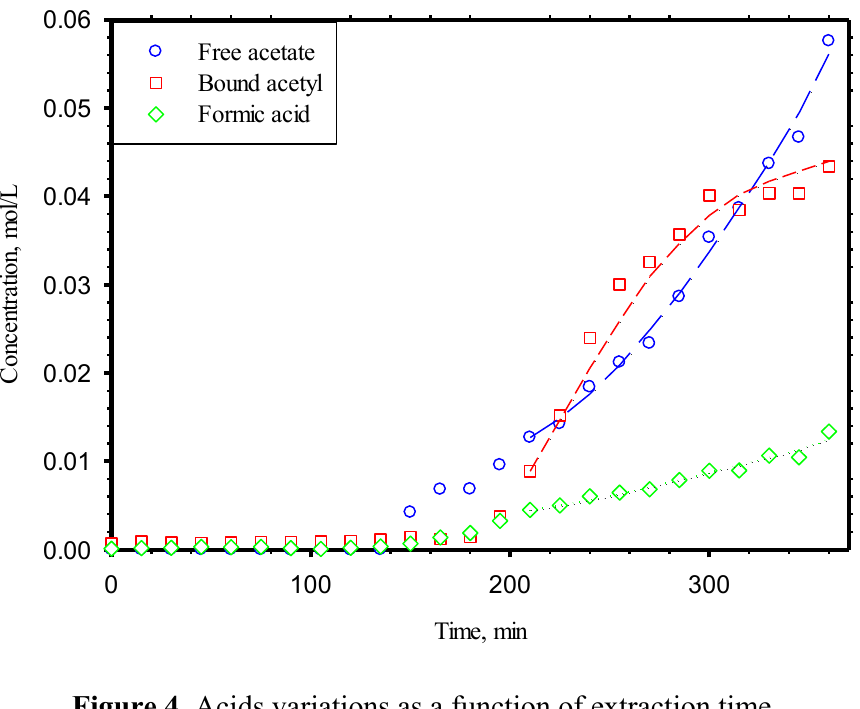
Figure 4. Acids variations as a function of extraction time. Table 1. Parameters of Equations (8)–(10) for